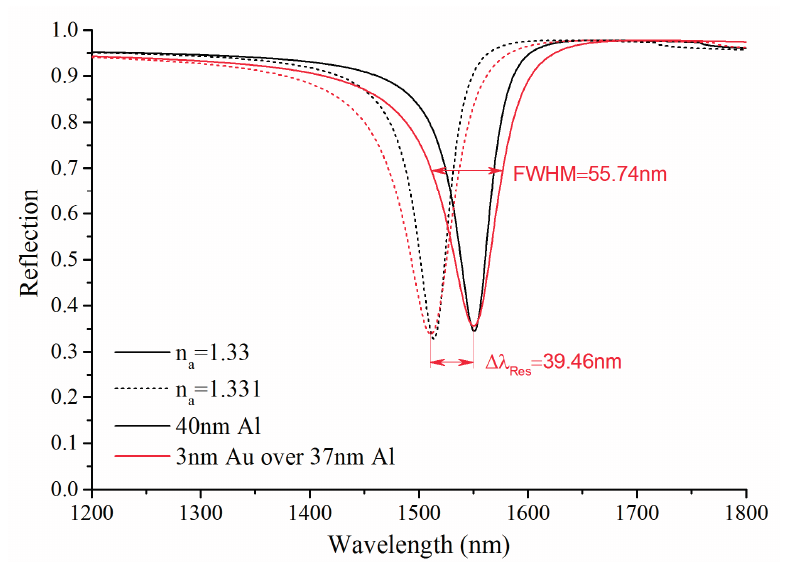
Figure 8. The comparison diagram of wavelength interrogation curve for single